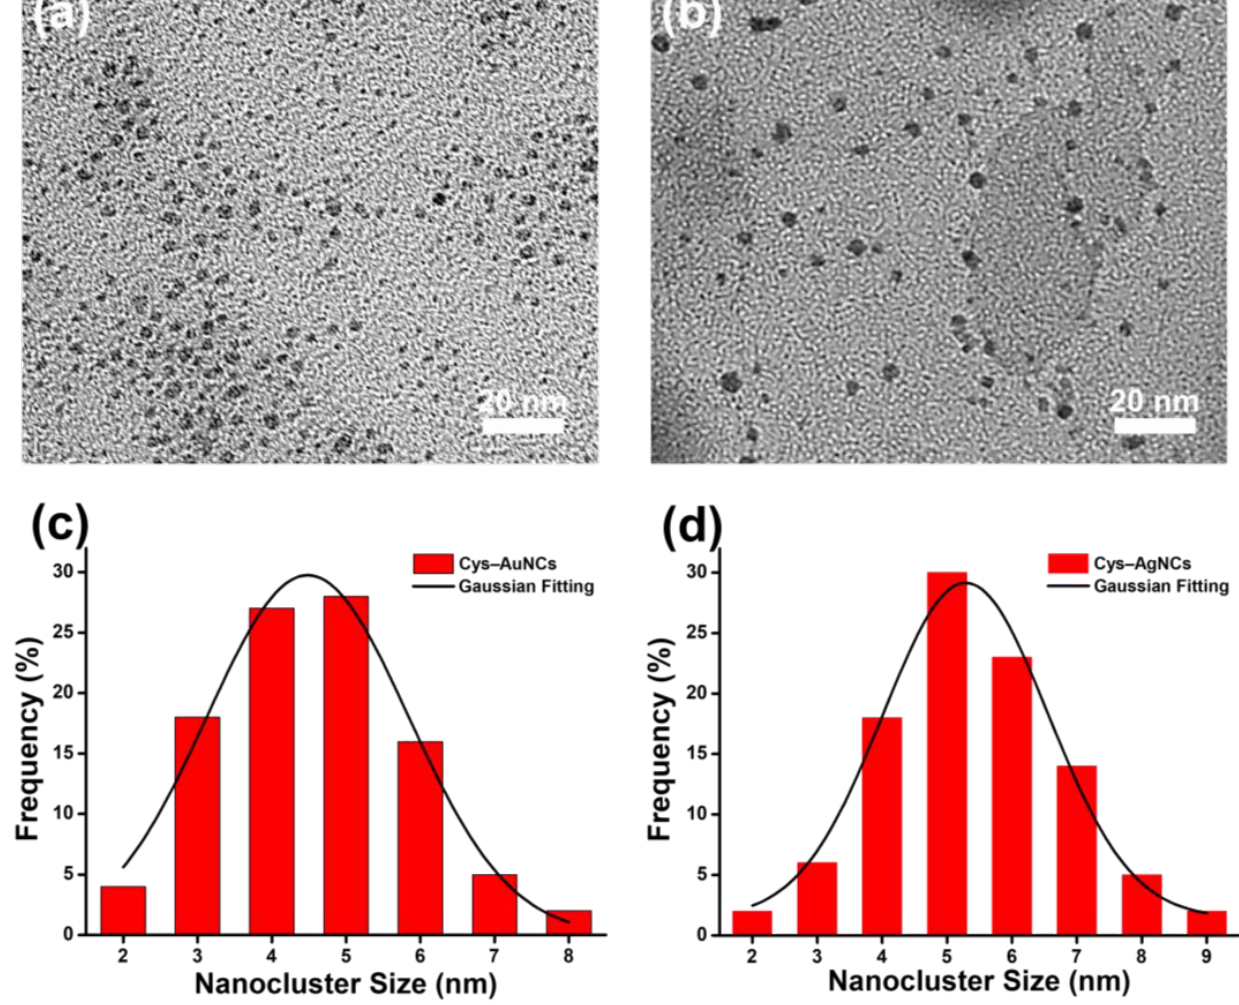
Figure 1. TEM images of the ( a ) Cys–AuNCs and ( b ) Cys–AgNCs. Histograms of the nanocluster size distributions and Gaussian fitting curves of the ( c ) Cys–AuNCs and ( d ) Cys–AgNCs. To further characterize the optical properties, UV–Vis spectra and fluorescence spec- tra of the Cys–AuNCs and Cys–AgNCs were separately examined using UV–Vis spec- troscopy (JASCO V-770 Spectrophotometer, Easton, MD, USA) and fluorescence